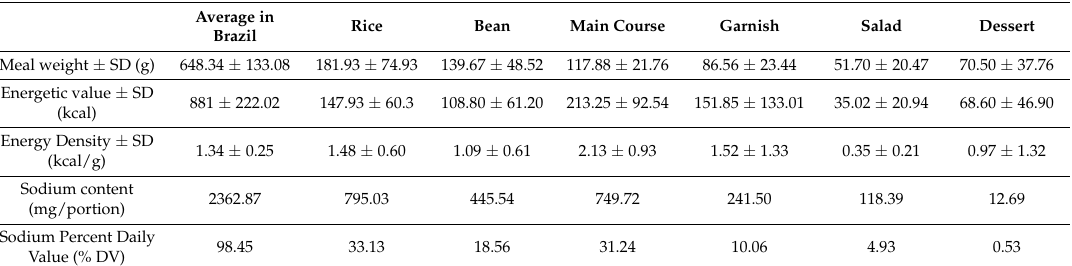
Table 1. Average and standard deviation (SD) of consumption (grams), total energetic value (TEV) Energy density (ED) and Sodium content of meals and preparations by low-income Brazilians in popular restaurants. Average in Brazil Rice Bean Main Course Garnish Salad Dessert Meal weight ± SD (g) 648.34 ±